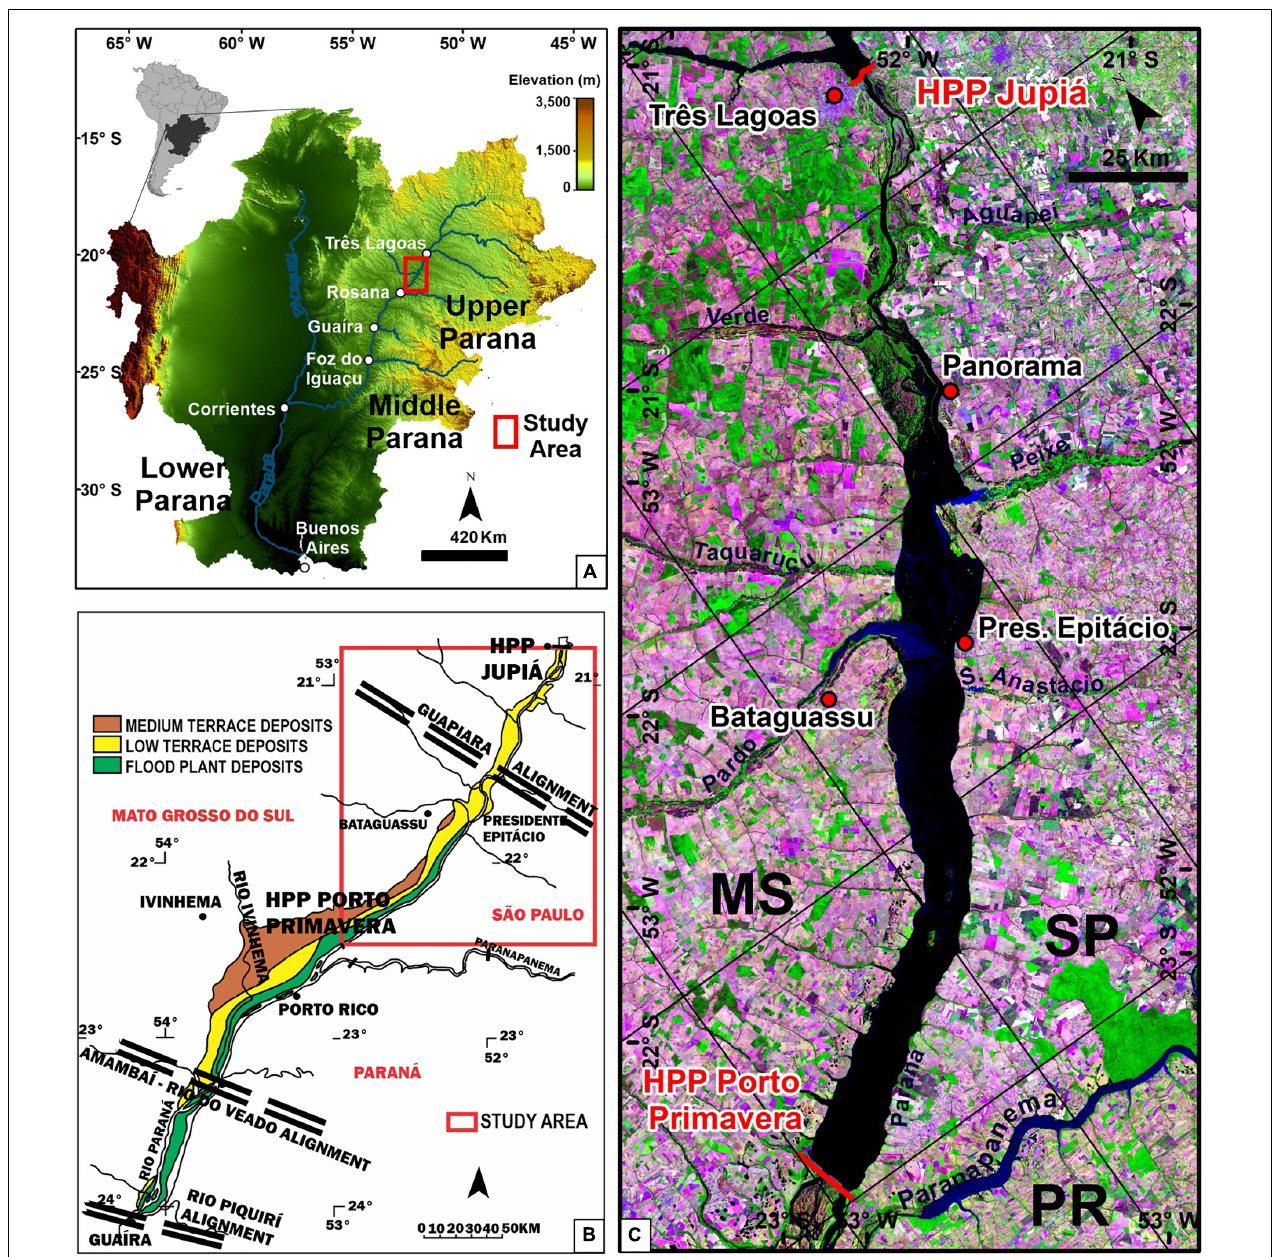
FIGURE 1 | Location of the Upper Paraná River. (A) The Paraná River Watershed and studied area in the upper stretch (red square). The Paraná River is divided into upper, medium, lower and tide influenced courses based on distinct geomorphological and hydrological characteristics; (B) Area between the Jupiá dam and Guaíra and deposits associated with the river channel of the Upper Paraná River, defined by geological control (modified by Souza Filho and Stevaux, 1997); (C) Study area is between the Jupiá and Porto Primavera Hydroelectric Power Plants – São Paulo and Mato Grosso do Sul states, Brazil (Landsat 8 image, composition 6R5G4B,